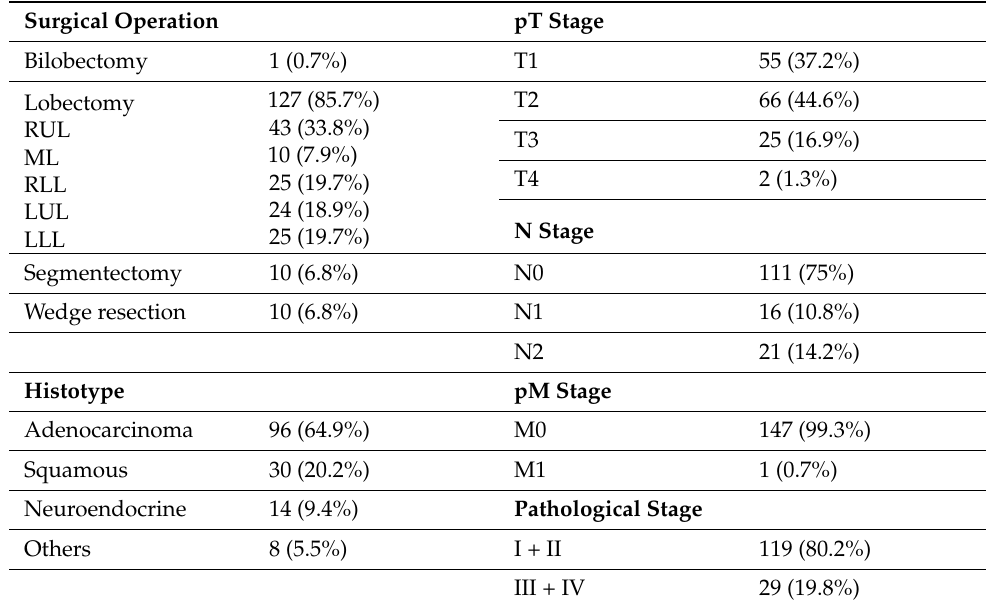
Table 2. Surgical and pathological characteristics of the population ( n = 148).